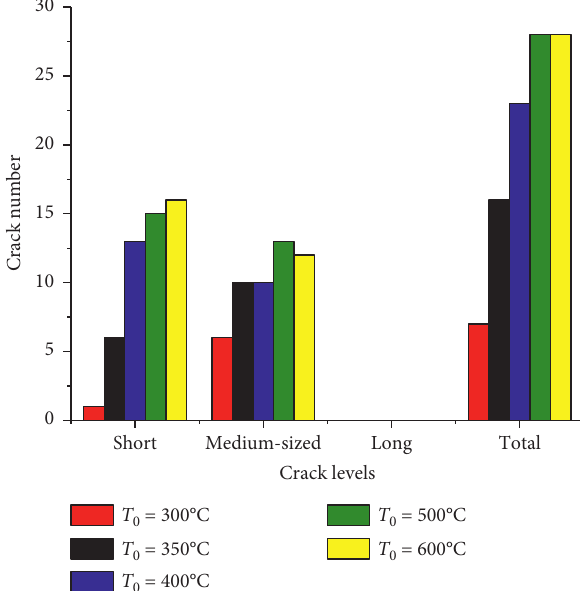
Figure 17: Thermal crack paths with different initial temperatures ( t � 1.0 s): (a) T (e) T 0 � 600 ° C.